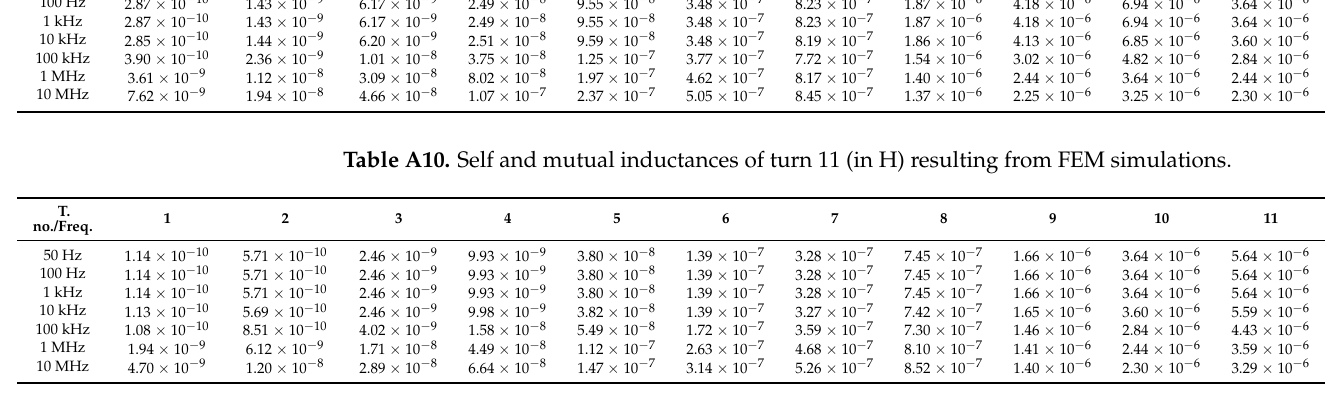
Table A9. Self and mutual inductances of turn 11 (in H) resulting from FEM simulations. T. no./Freq.